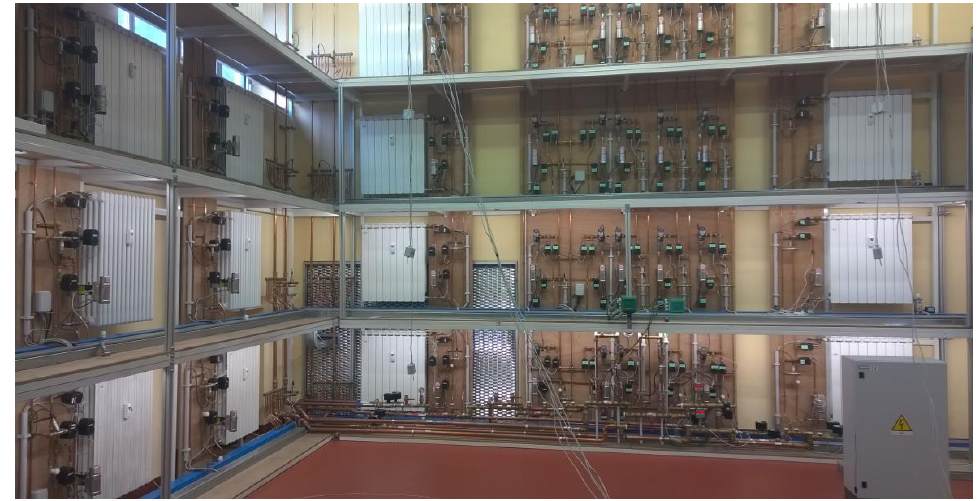
Figure 6. Experimental setup at the INRIM central heating system test facility.